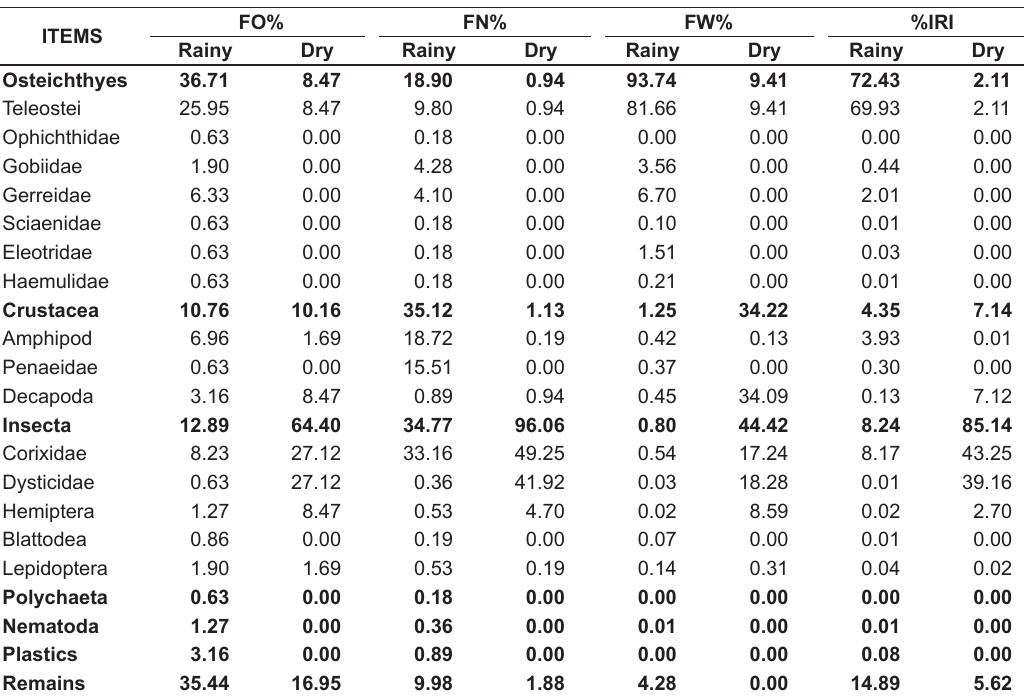
Figure 4. Frequency numerical (FN) and Gravimetric (FW) on diet of juvenile Elops saurus in the Parnaiba Delta River in the period between July (2016) to May (2017). Table 1. Seasonal analysis for Frequency of occurrence (FO%), Frequency numerical (FN%), Frequency Gravimetric (FW%) e Relative Importance Index (%IRI) on diet of Elops saurus in Delta do Rio Parnaíba (PI) between July 2016 and April